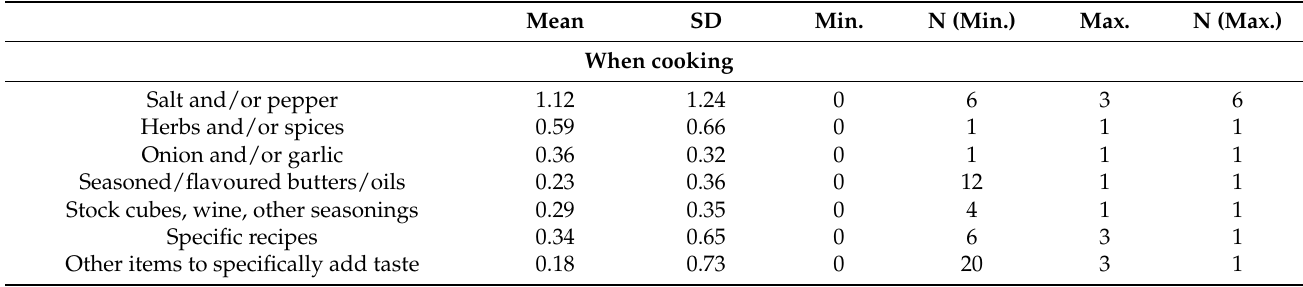
Table 1. Mean, SD, minimum and maximum frequency (times per day) of adding flavours to foods or meals when cooking and when eating, and number of participants reporting minimum and maximum use ( N =